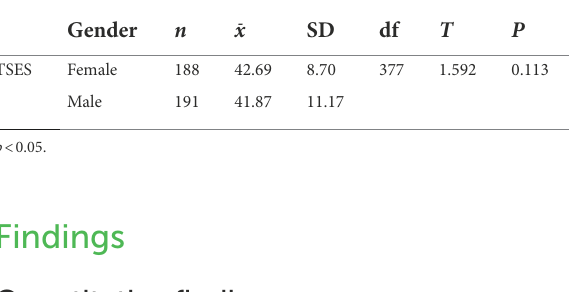
TABLE 3 “ T -test” results to analyze “TSES” for